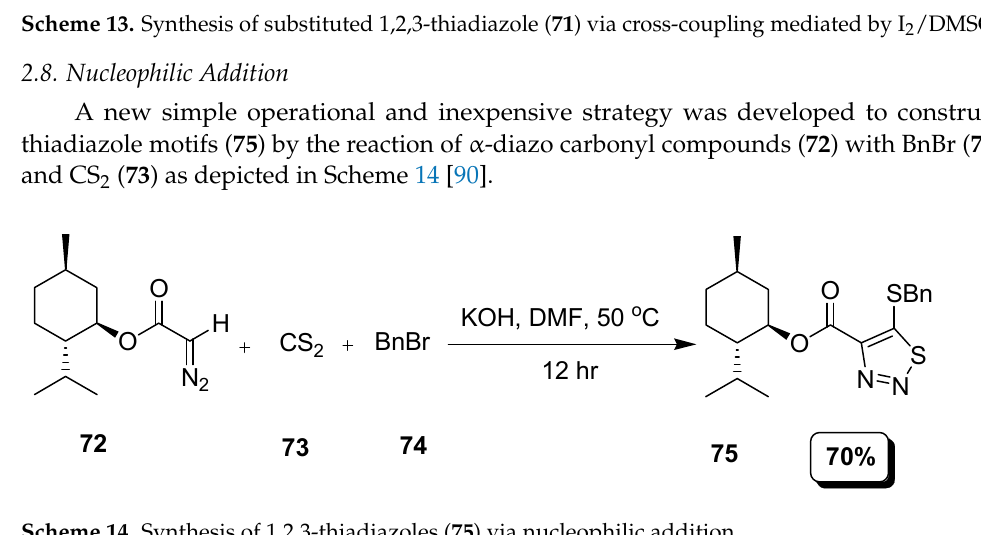
Scheme 14. Synthesis of 1,2,3-thiadiazoles ( 75 ) via nucleophilic addition.